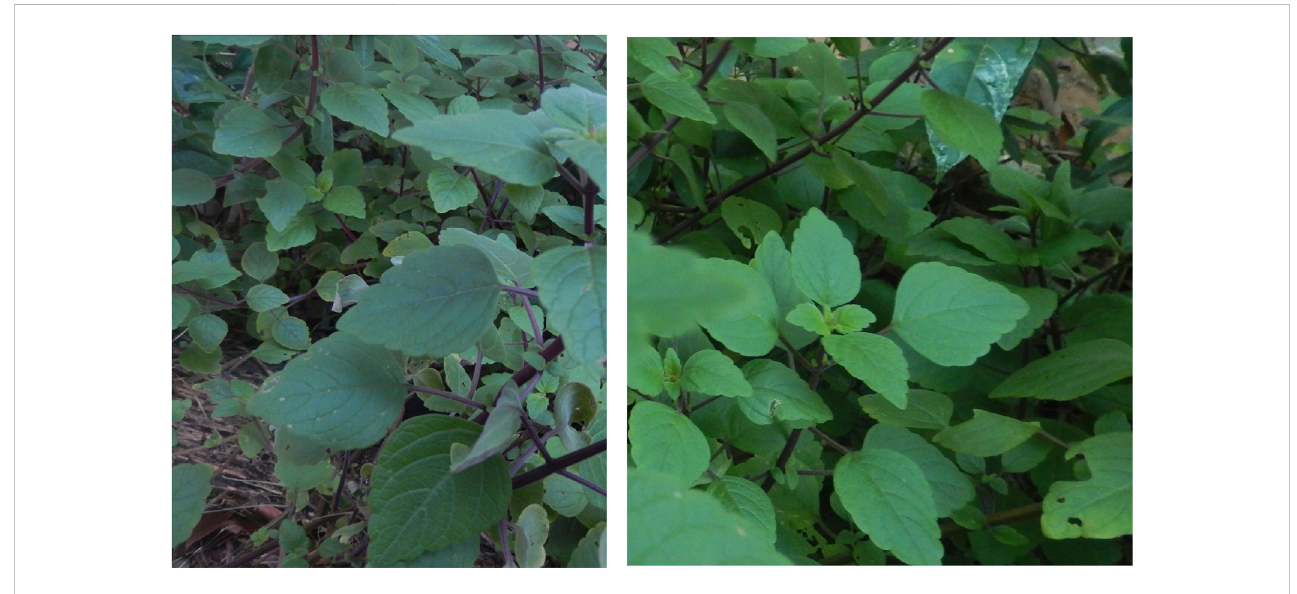
FIGURE 1 Coleus forsteri (Benth.) A.J. Paton (2019). Photos by Dr Edouard